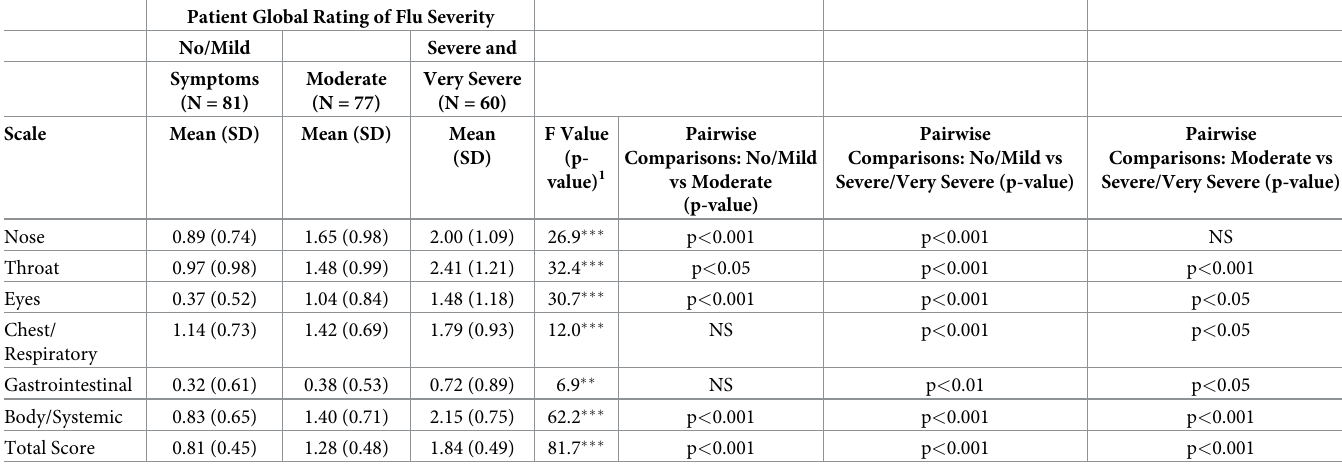
Table 5. Known-groups validity: FLU-PRO scores by patient global rating of disease severity, Day 1.